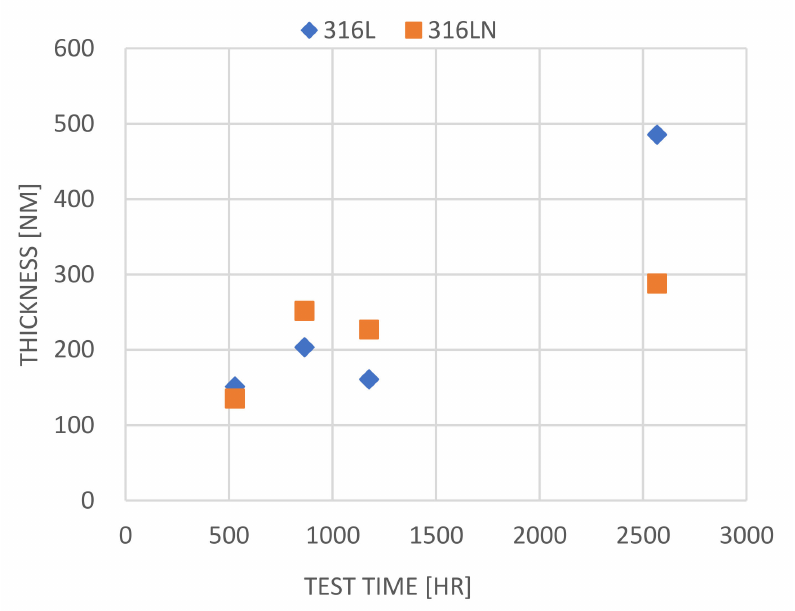
Figure 12. Relation between oxide film total thickness and testing time obtained under irradiation condition by using a plate type